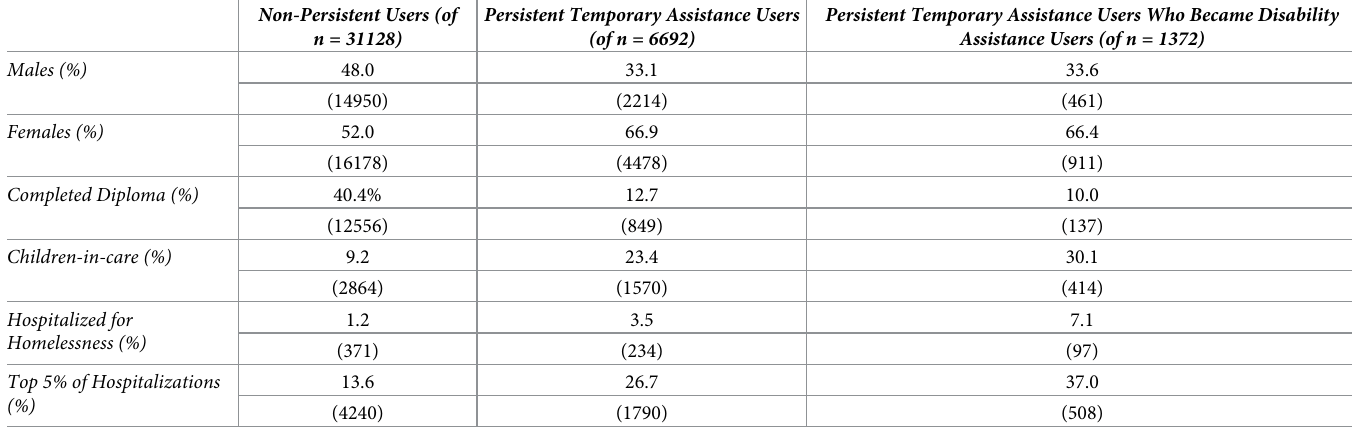
Table 4. Characteristics of British Columbia employment assistance program—temporary assistance users by length of program use (persistent use defined as > 7 years using the temporary assistance stream, half of the study period), and whether these persistent users transitioned to Disability Assistance